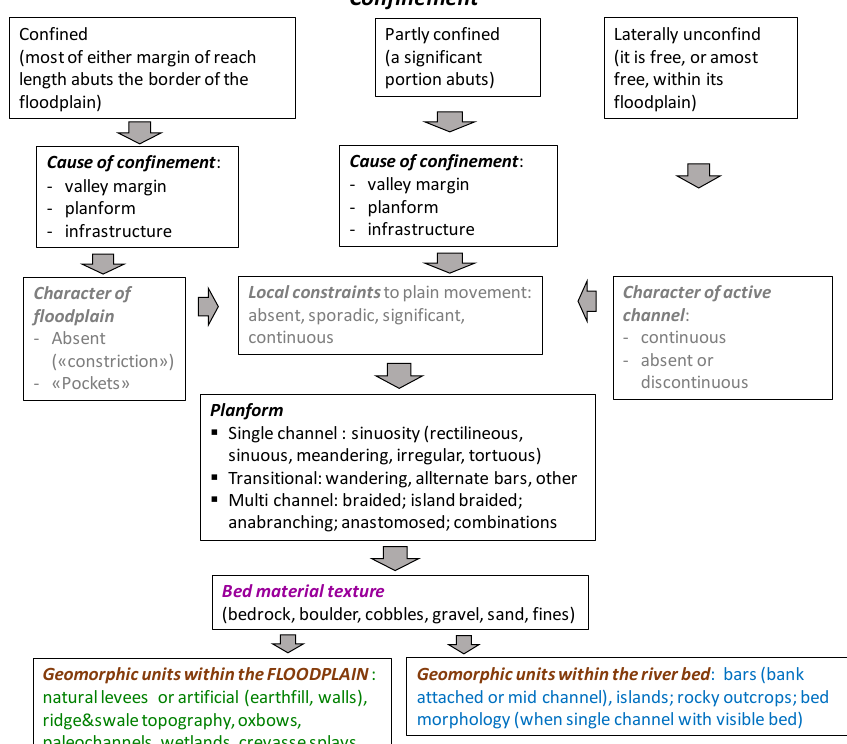
Figure 2. Structure of the modified procedural tree once specified for the Magdalena River. Bold is used to identify the fundamental attributes; bold grey attributes, although fundamental, were not considered in the Magdalena case because of lack of information or nonoccurrence. The plain text words just describe possible values of the attributes.